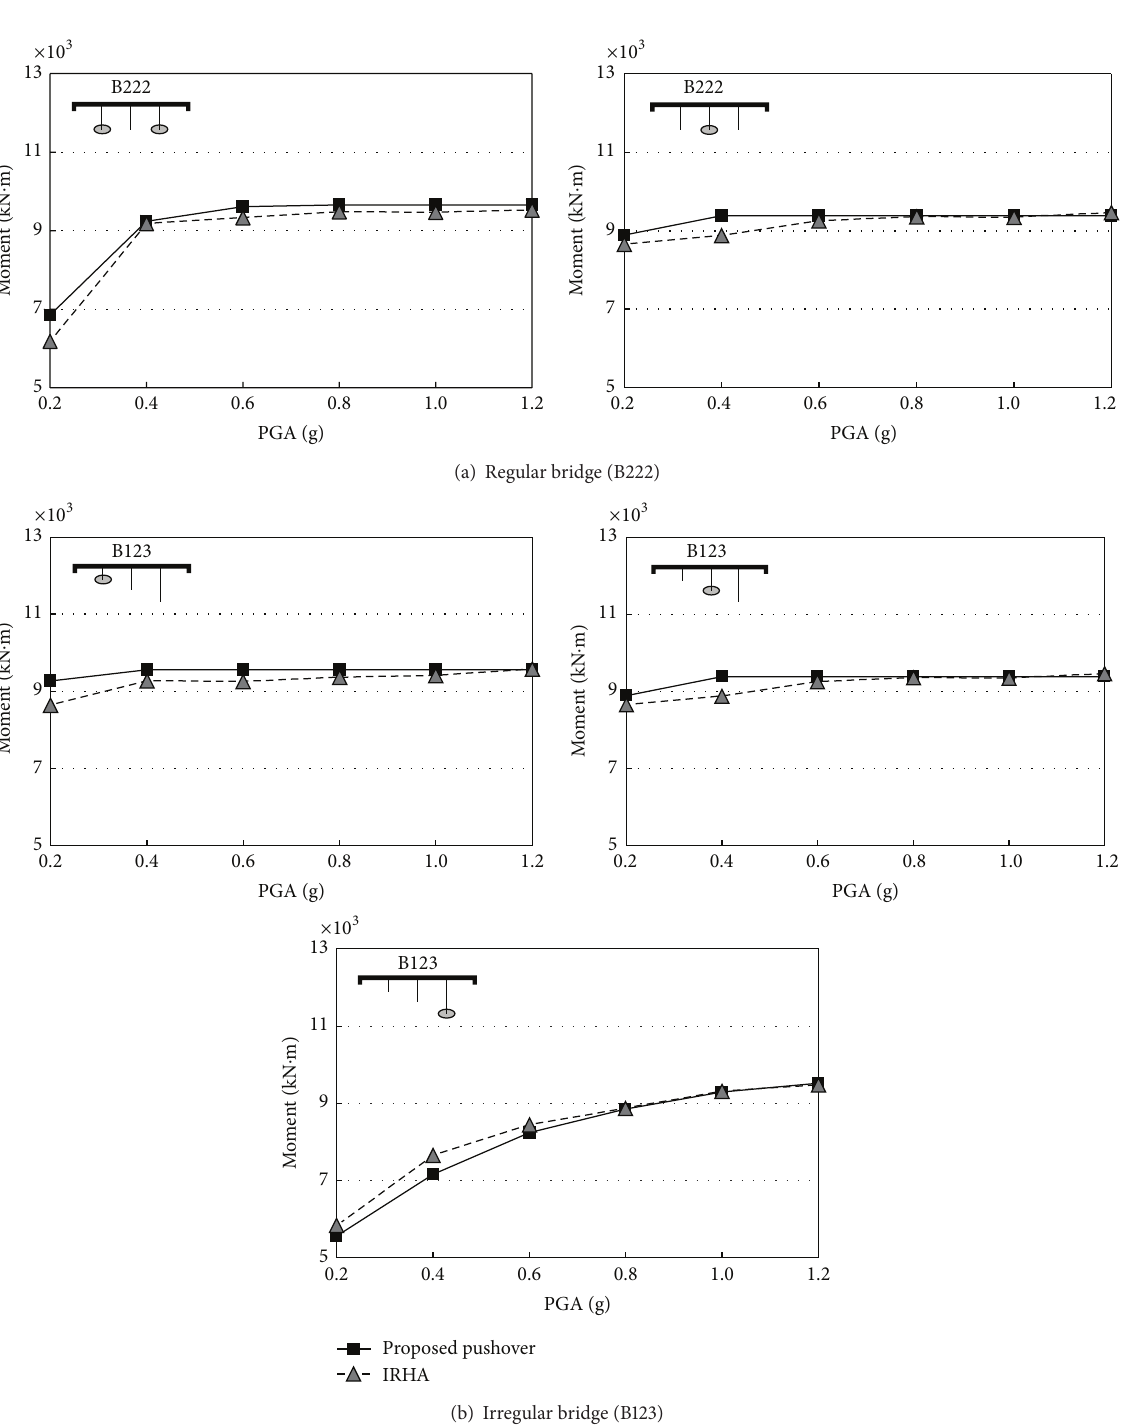
Figure 11: Column base moments of B222 and B123 under Tabas record (PGA = 0.2 g −